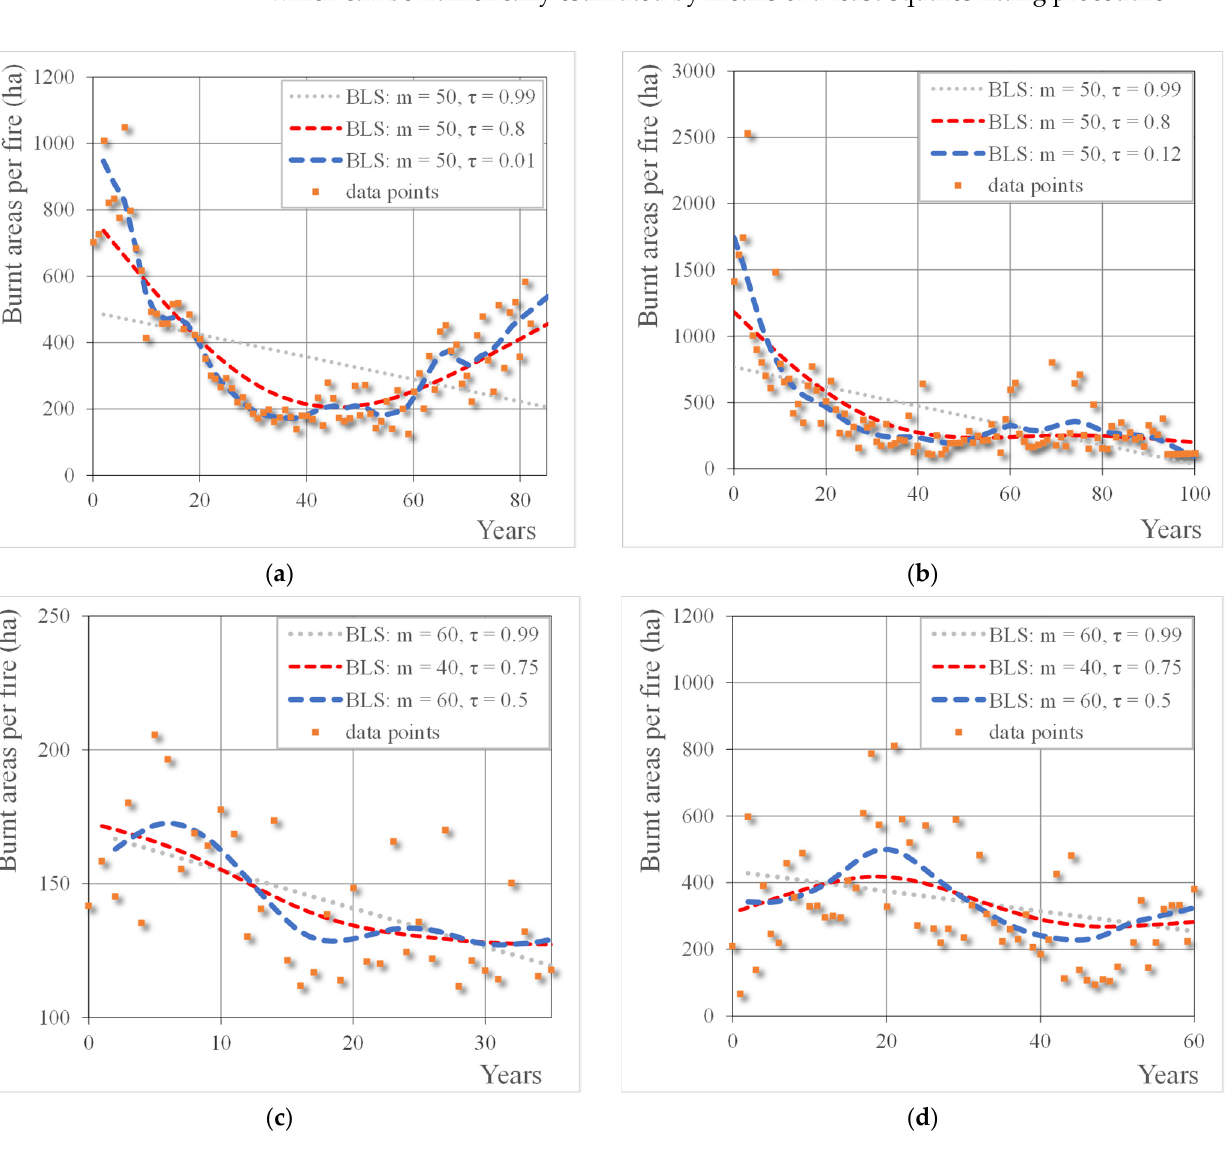
Figure 5. Burnt areas per number of fires (annual ratio). Dash lines show the trend of the phenomenon adopting alternative parameters of BLS. ( a ) US data: 1926–1970 and 1983–2021; ( b ) Canada data: 1920–2013; ( c ) Mediterranean countries data: 1980–2016; ( d ) Greece data: